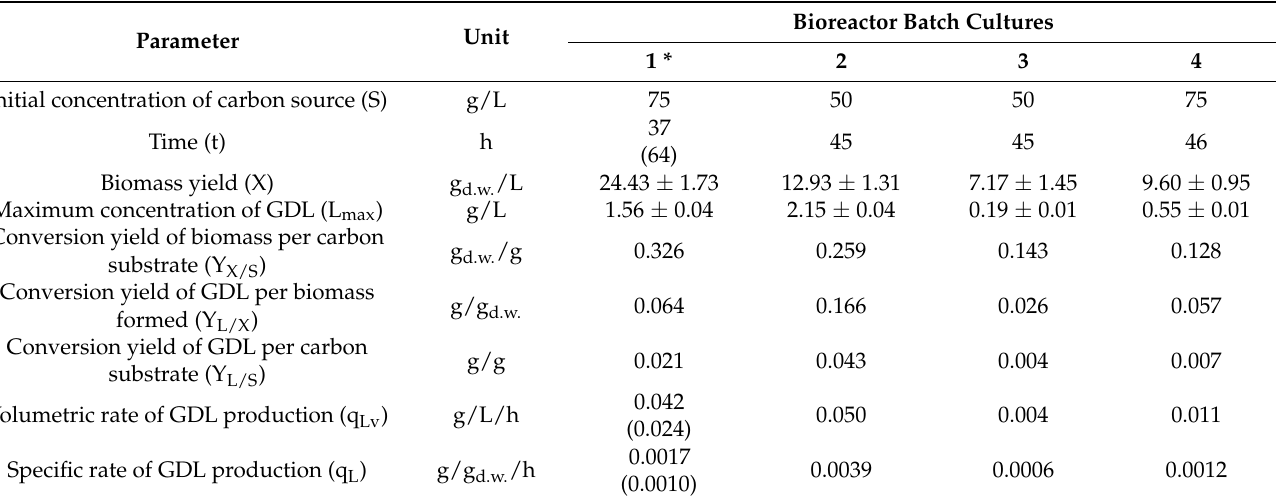
Table 3. Kinetic parameters of γ -decalactone biosynthesis in batch bioreactor cultures of Y. lipolytica , according to the L4 orthogonal